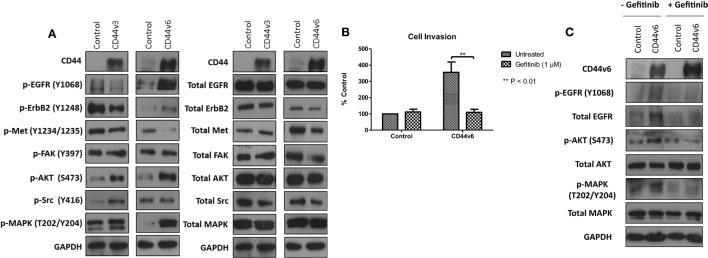
CD44v6 overexpression enhances EGFR pathway activity in MCF-7 cells. Western blotting analysis was used to assess the effects of CD44v3 and CD44v6 overexpression in MCF-7 cells on endogenous EGFR and Met pathway activity. (A) CD44v6 overexpression in MCF-7 cells significantly reduced endogenous EGFR, AKT, and MAPK phosphorylation, whereas these effects were not seen in MCF-7 cells overexpressing CD44v3; no changes in total protein levels were observed. (B) Treatment of CD44v6-overexpressing cells with gefitinib suppressed their invasive behavior together with EGFR pathway activity (C).